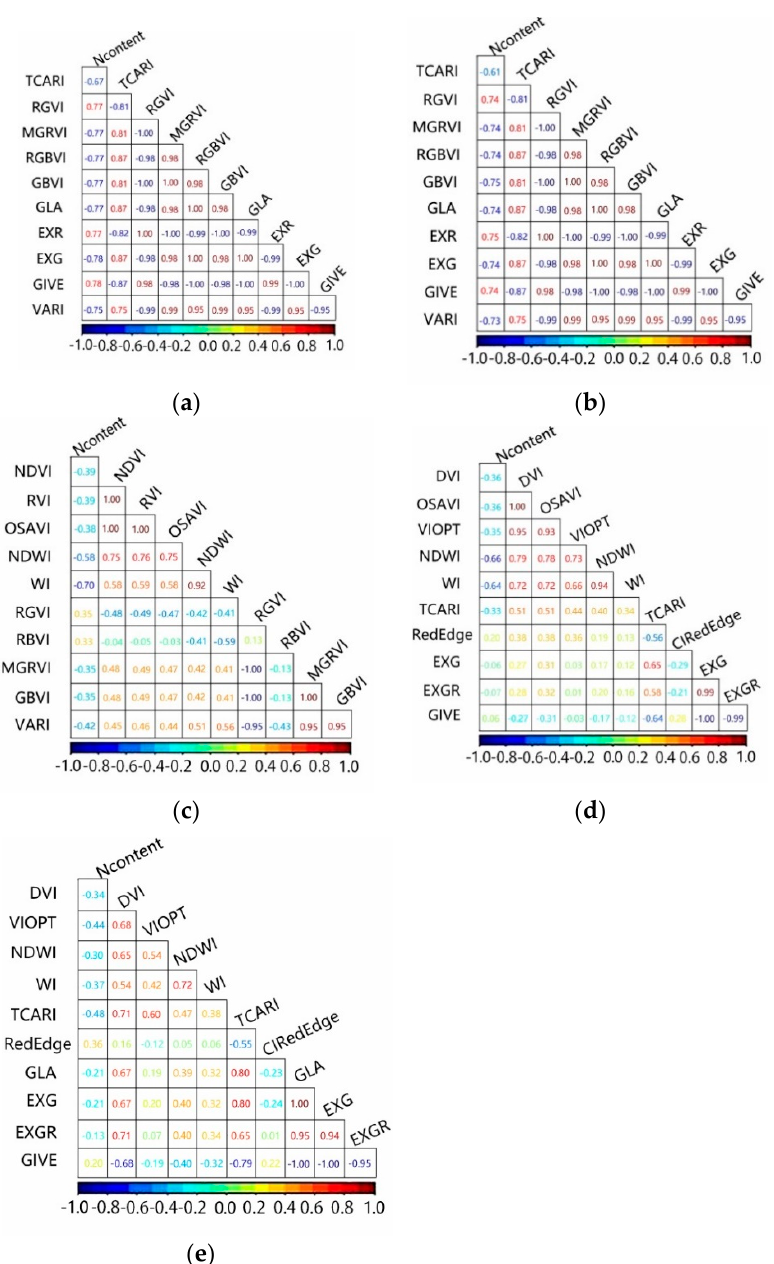
Figure 3. Correlation matrix between vegetation indices and leaf nitrogen content for different leaf positions. ( a ) Flag leaf; ( b ) upper 1 leaf; ( c ) upper 2 leaf; ( d ) upper 3 leaf; ( e ) upper 4 leaf. Based on the results of the correlation analysis between the nitrogen content of leaves at different leaf positions and vegetation indices, the vegetation indices with high correlation were screened and the results are shown in Table 4. Table 4. Correlation between vegetation indices and nitrogen content from different leaf positions in winter wheat.